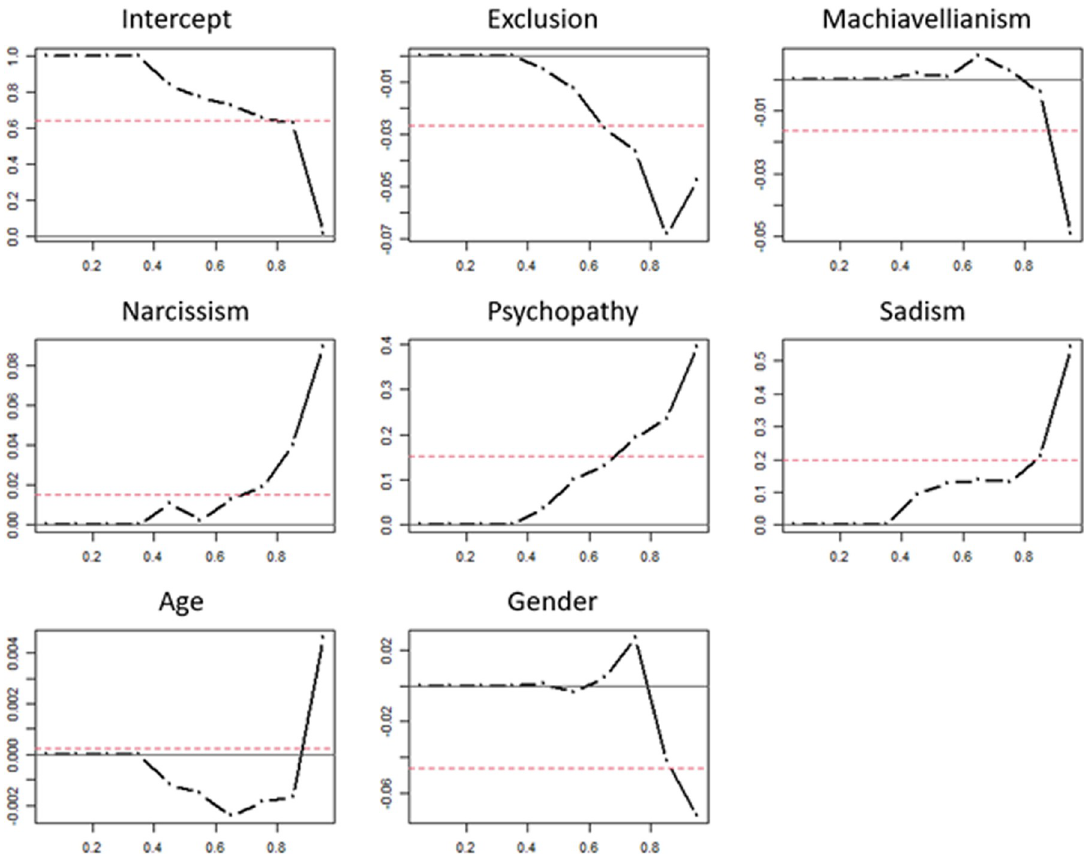
Fig 1. Graphs of the quantile regression coefficients for all independent variables. Note . Simple linear regression coefficients (red line) and quantile regressions for exclusion, Machiavellianism, narcissism, psychopathy, sadism, age, and gender (male with female as the comparison group) for the dependent variable immediate trolling motivation. The x-axis represents the quantiles for immediate trolling motivation while the y-axis represents the unstandardized coefficients of the respective independent variable.